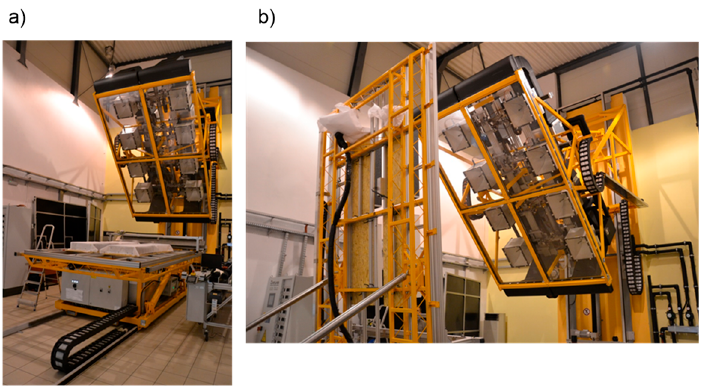
Figure 7. Solar radiation simulator. ( a ) location of samples in the horizontal plane, ( b ) location of samples in the vertical plane.